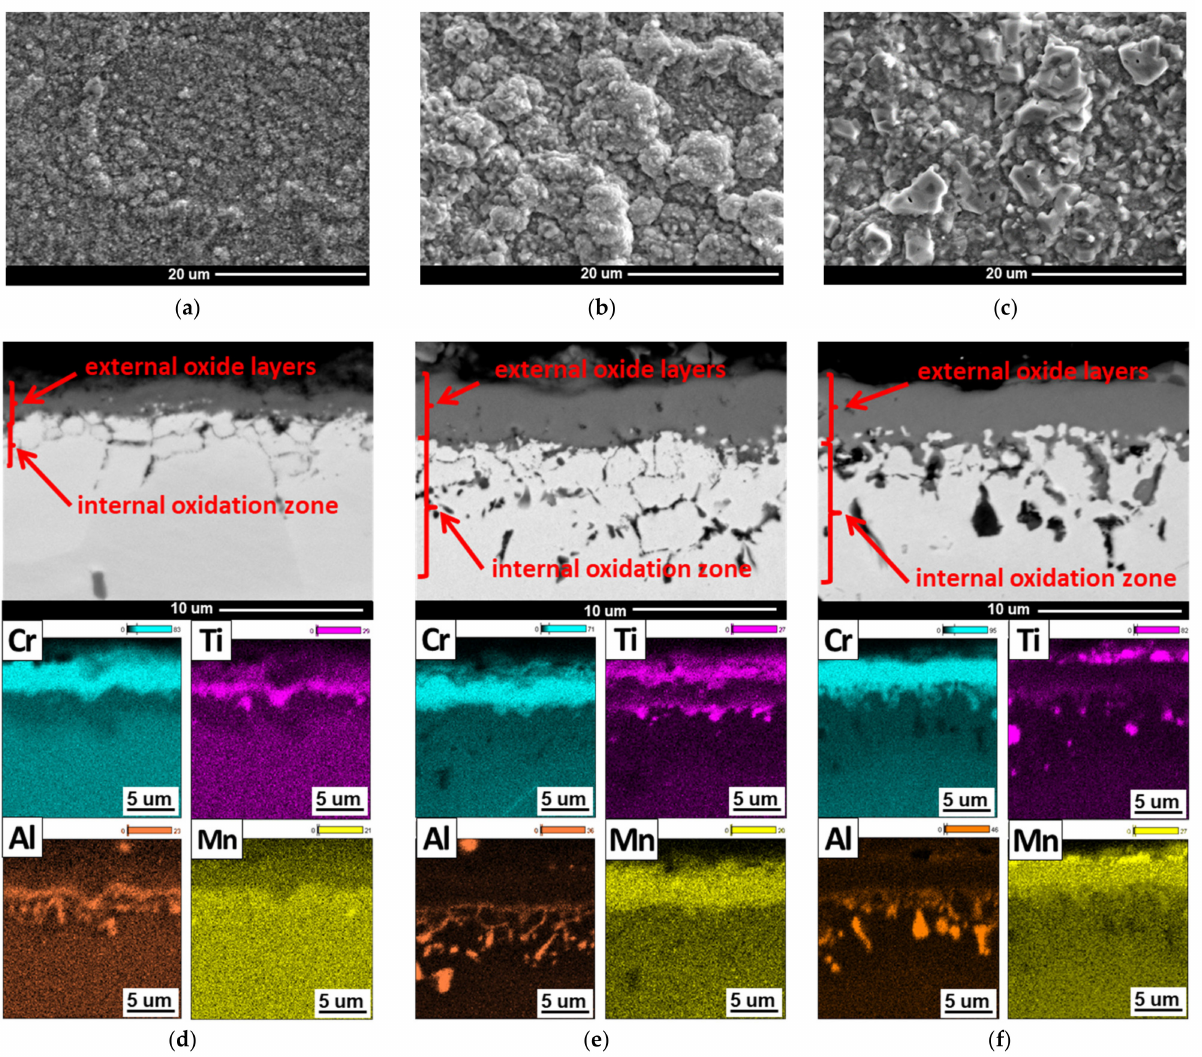
Figure 5. Microstructure of surface ( a – c ) and chemical composition of oxides ( d – f ) formed during steam oxidation at 750 ◦ C. SEM and EDS: ( a , d ) 100 h; ( b , e ) 1000 h; and ( c , f ) 2000